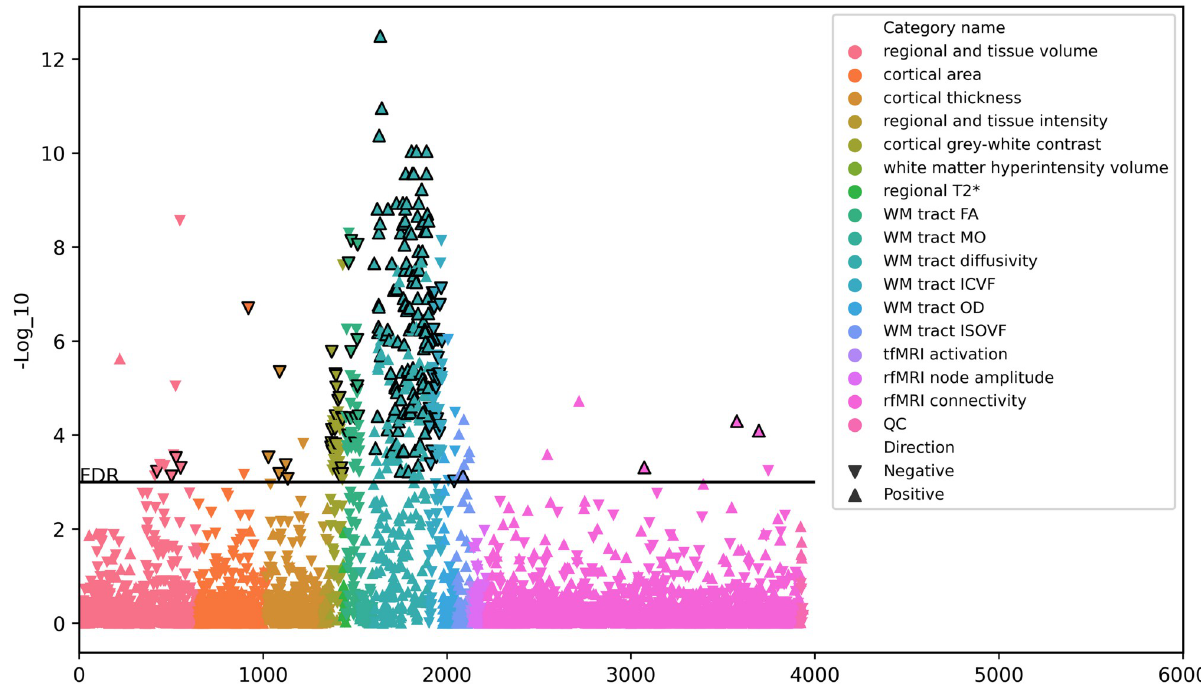
Fig 1. The causal association of TL and brain IDPs using the IVW method. The y-axis represents the − log 10 ( p − values) of the association. The color of each IDP indicates the MRI modality and the triangle shape indicates whether the identified association (IVW β value) is positive ( 4 ) or negative ( 5 ). The black horizontal line indicates the FDR-adjusted significance threshold ( P = 0.004409). The triangles with black border highlight the 193 IDPs that were significantly associated with TL using the IVW method as well as the complementary MR analyses. WM: white matter; FA: fractional anisotropy; MO: diffusion tensor mode; OD: orientation dispersion; ICVF: intracellular volume fraction; ISOVF: isotropic volume fraction; tfMRI: task fMRI; rfMRI: resting-state fMRI; QC: quality control.